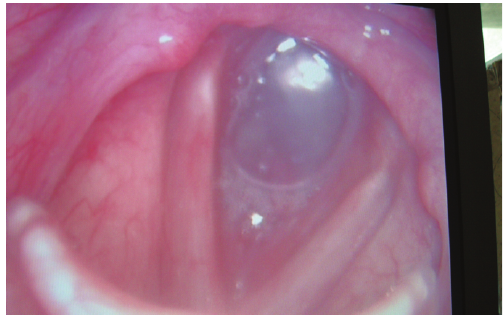
Figure 1: X-ray chest showing tracheostoma in the stent with bi- lateral chest drains in situ . Figure 2: Granulation tissue blocking the proximal trachea from subglottis to the tracheostomy